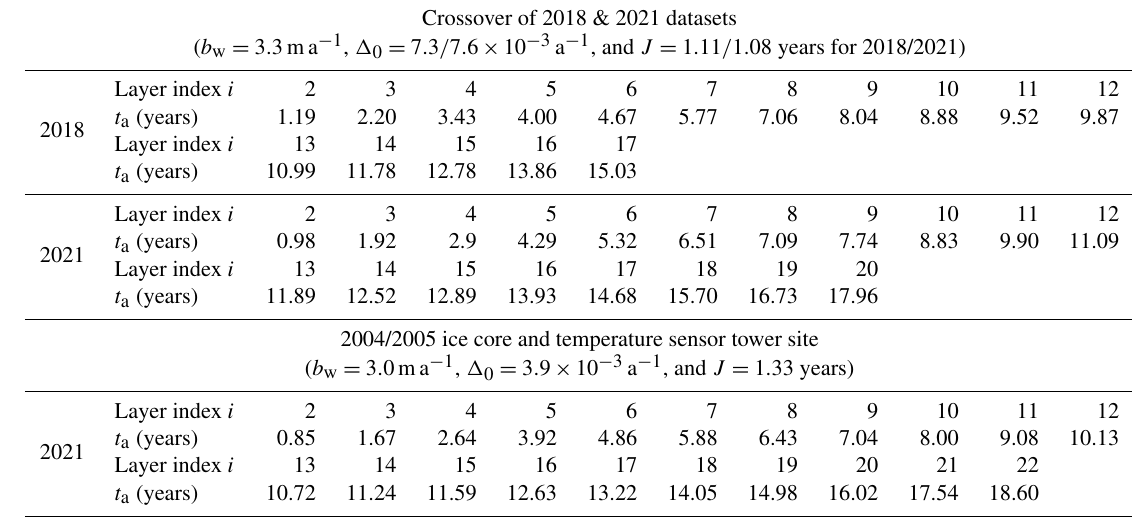
Table 2. Estimated depositional ages of tracked layers.